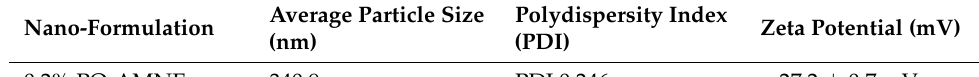
Table 6. Physical characterization of 0.2% PO-AMNE.